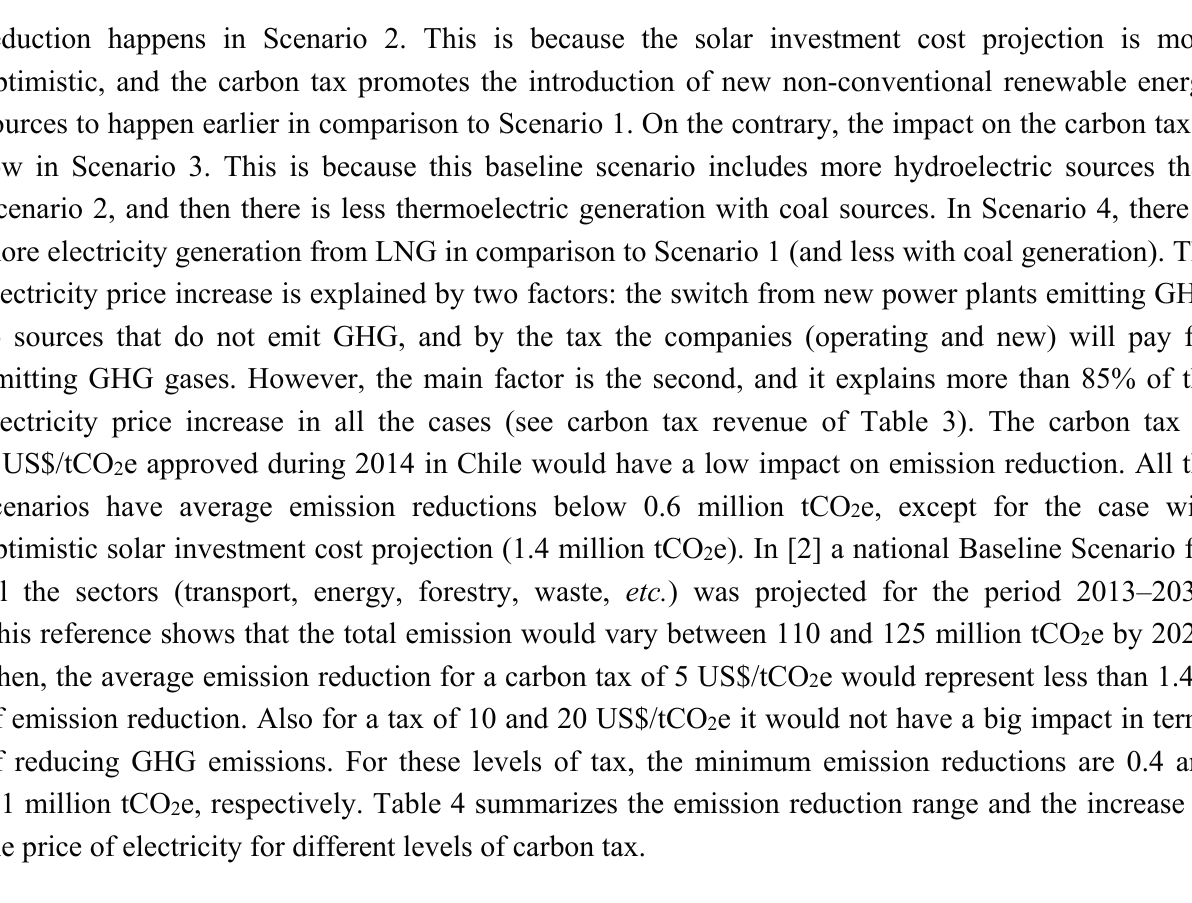
Table 4. A summary of the emission reduction and electricity price rise range of Table 3. These values are compared with the baselines scenarios (without carbon